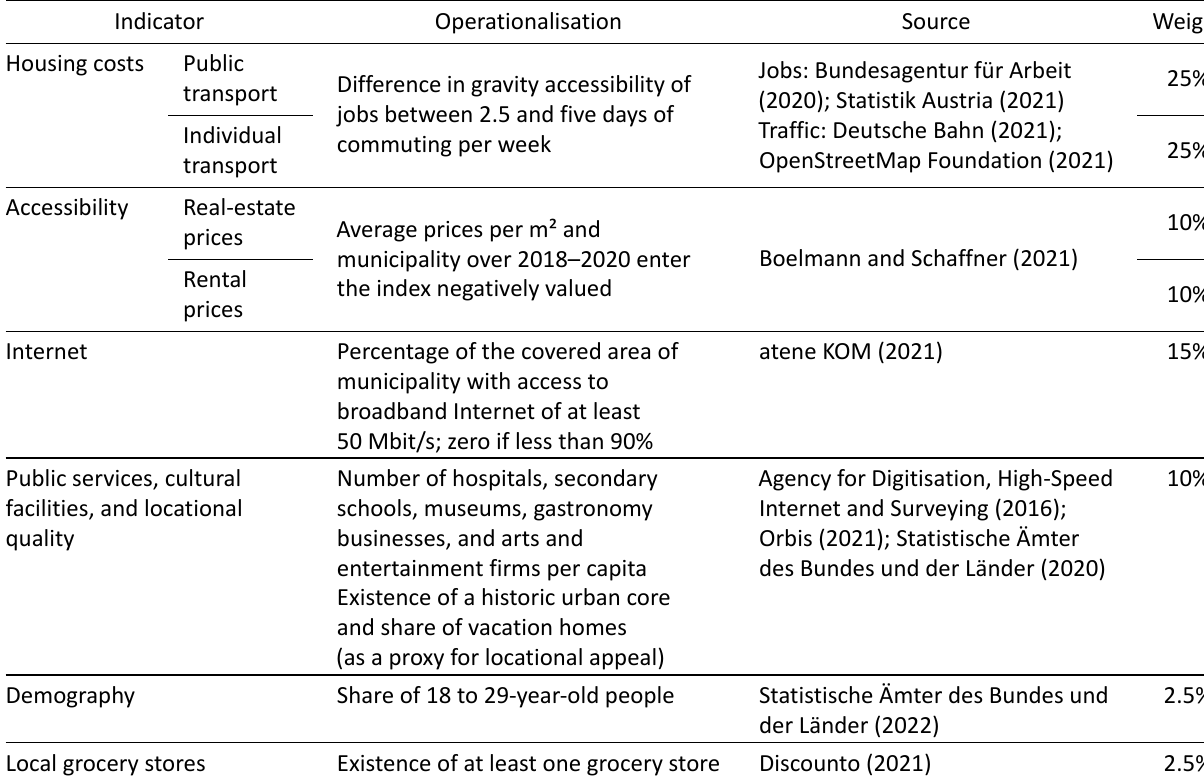
Table 1. Description of WFH